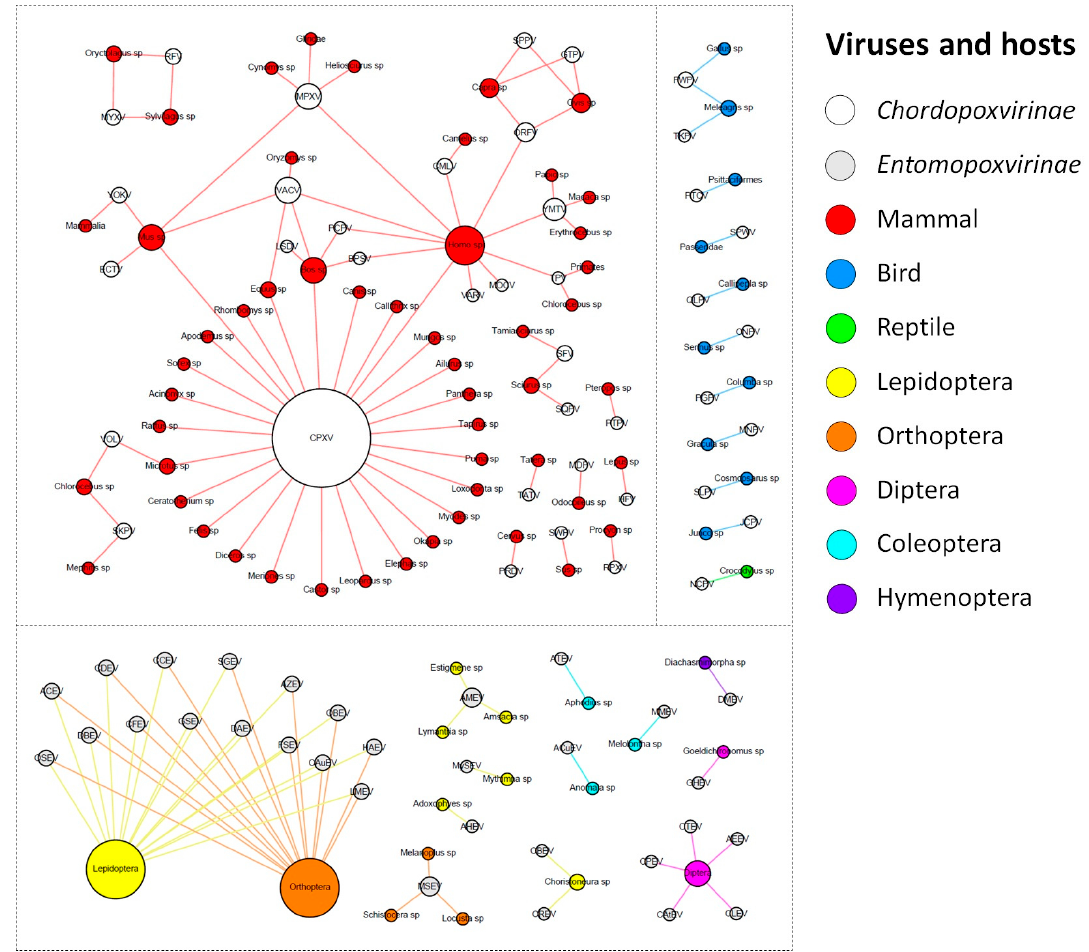
Figure 1. Poxvirus host network. The poxvirus species and their hosts (taxonomic level of genus or higher) are depicted in the graph. The network layout was generated by applying a force-based algorithm, followed by manual rearrangement of the nodes. The full names of the viral species are listed in Supplementary Table S1.